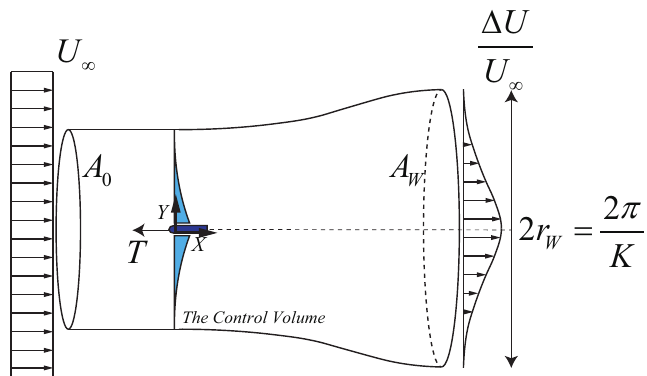
Figure 3. Assumption of the trigonometric distribution for velocity